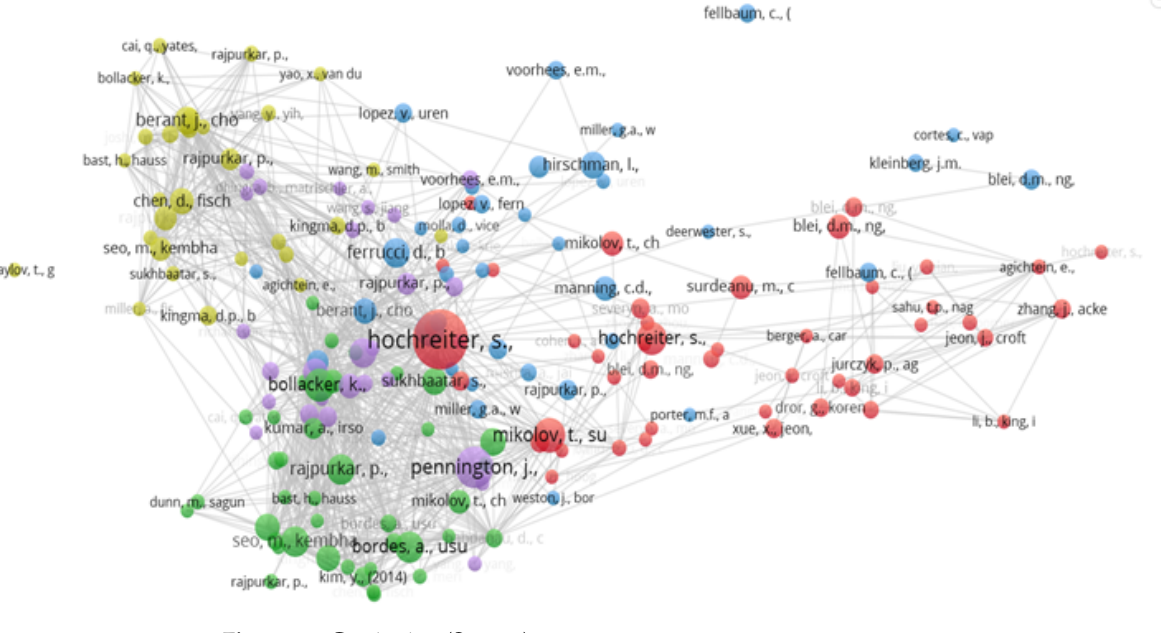
Figure 12. Co-citation